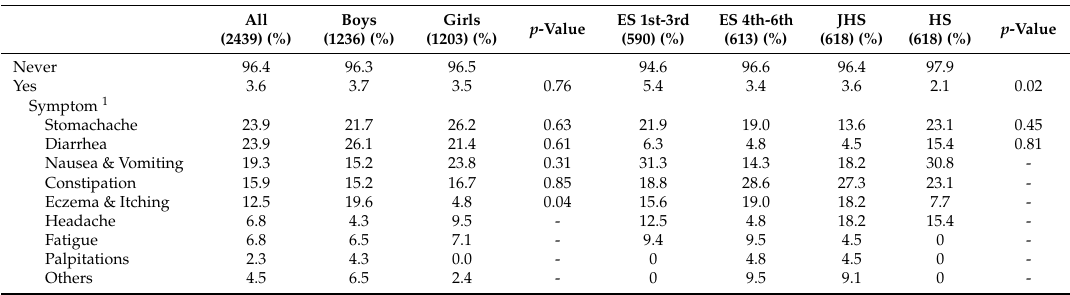
Table 7. Has your child ever experienced adverse events due to dietary supplement use? If yes, what symptom(s) did your child experience?